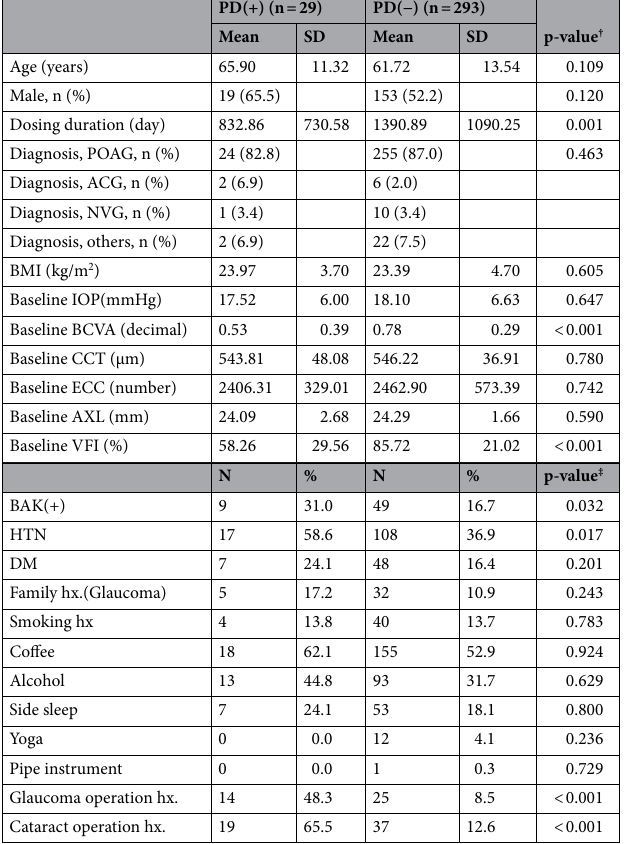
Table 2. Clinical characteristics of study subjects (PD(+) vs PD(−) groups). Values are presented as mean ± standard deviation unless otherwise indicated. PD periorbital dermatitis, POAG primary open-angle